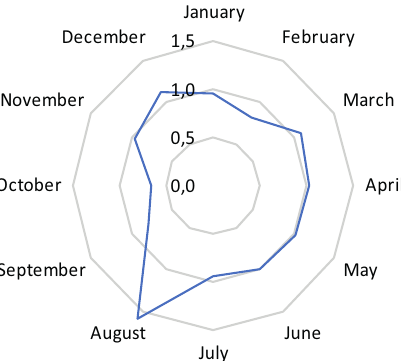
Figure 3. Seasonal indices of mortality among population over 15 years in the Pokrovsky parish, 1877-1897, both sexes. Source: author’s calculations based on parish registers.